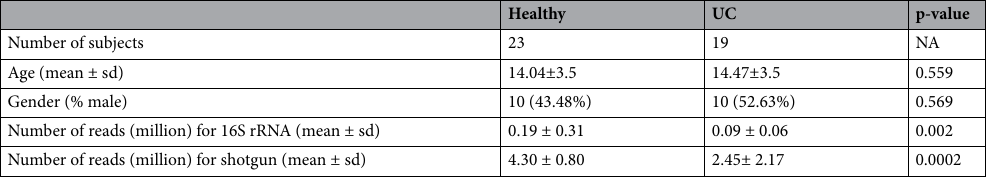
Table 1. Metadata demographics. There are no age and gender differences between the UC cases and healthy controls. However, the numbers of reads for the healthy controls are much higher than that for the UC cases for both the 16S rRNA and shotgun sequencing data. Statistical significance (p-value) for the differences was calculated using the Wilcoxon rank-sum